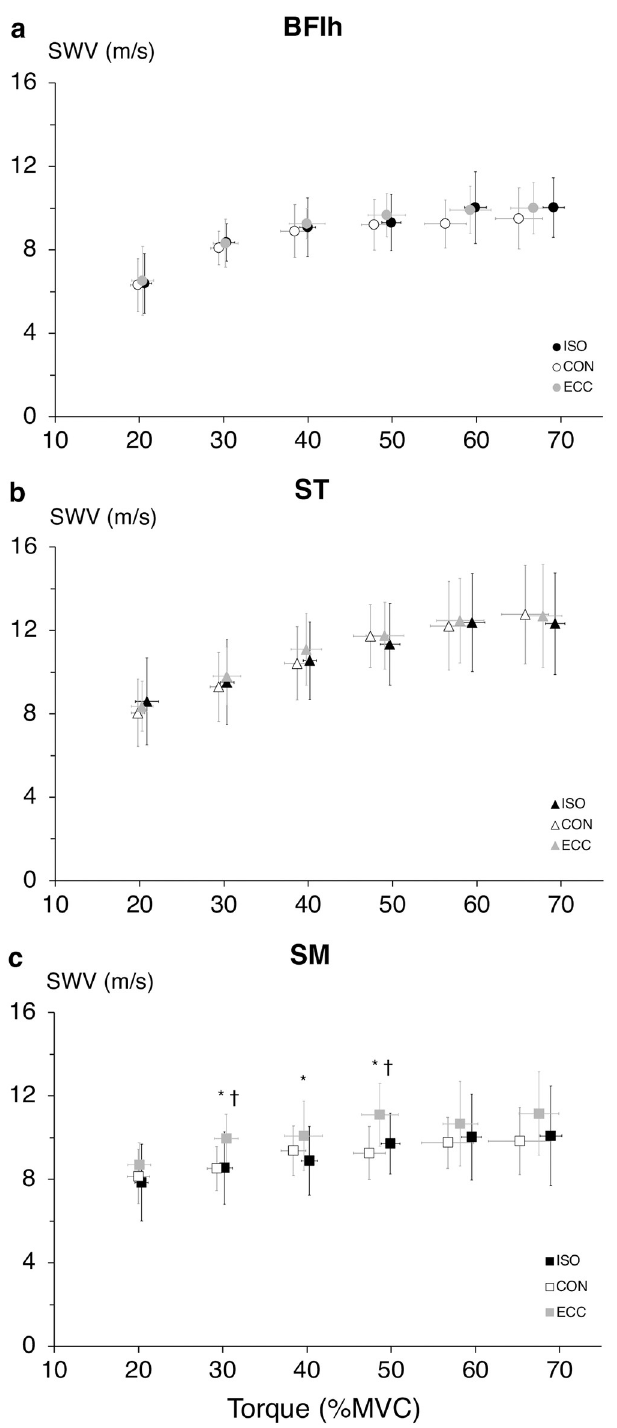
Fig 3. Within-contraction type comparison of the shear wave velocity–torque relationship for each hamstring muscle. Comparison of the shear wave velocity (SWV)–torque relationship in biceps femoris long head (a), semitendinosus (b) and semimembranosus (c) across the isometric (ISO, black), concentric (CON, white) and eccentric (ECC, grey) conditions. Data are presented as mean ± SD of the average across the duplicate measurements. � different from ISO, † different from CON, p <